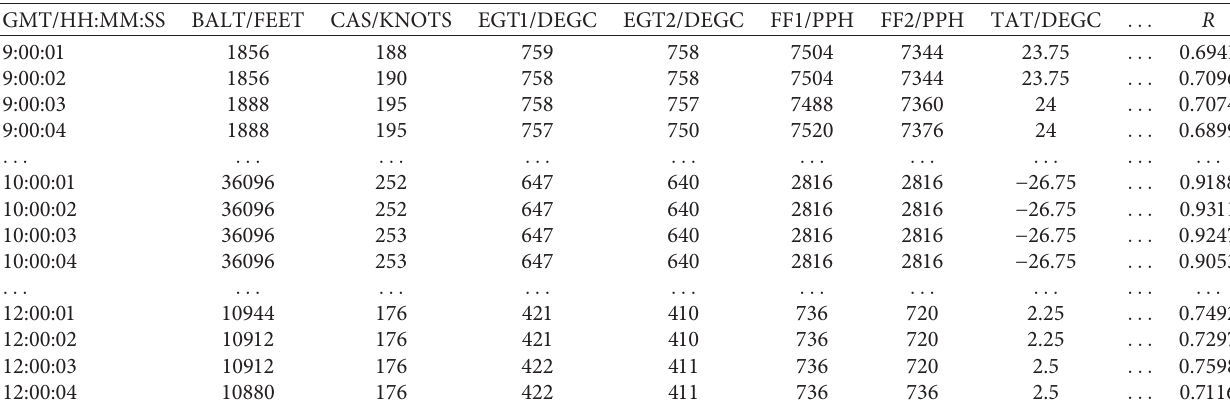
Table 2: The analysis results of R and QAR